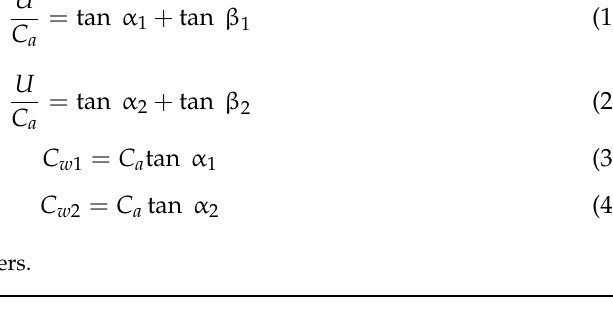
Table 1. Initial rotor design parameters.